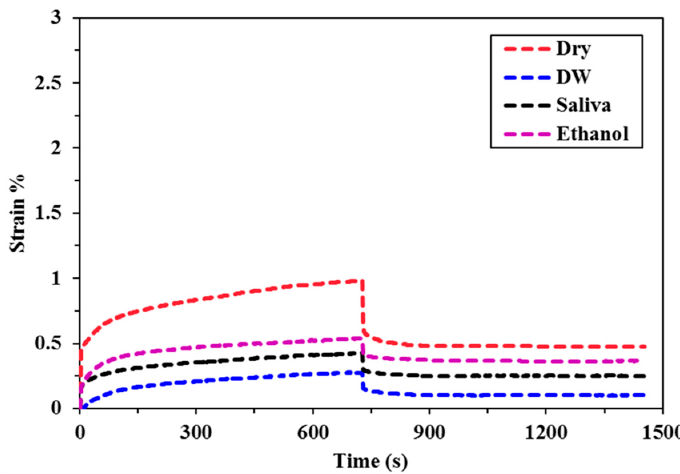
Figure 3. Creep deformation and recovery of the conventional material (GR) in various FSOS.